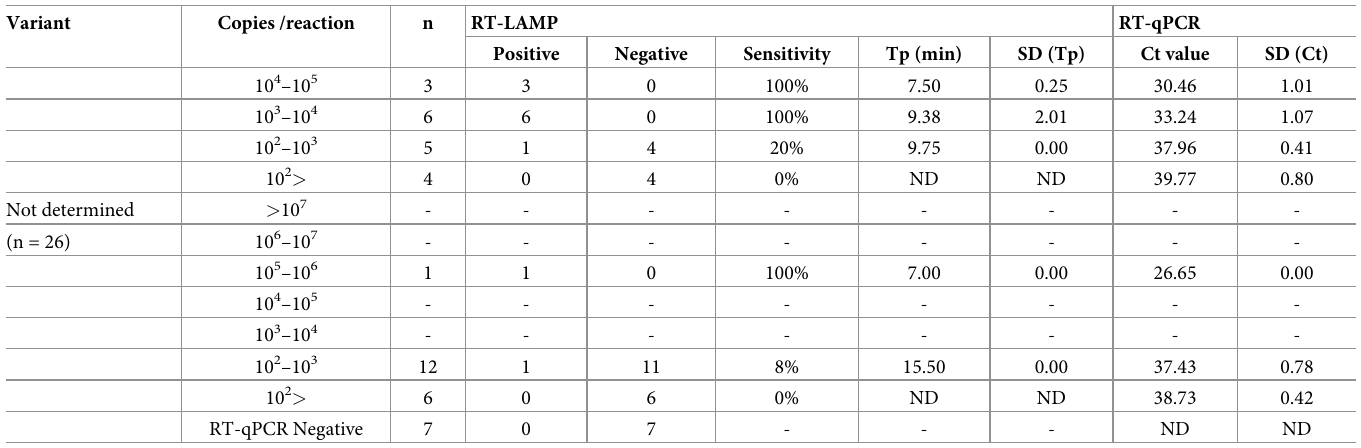
ND, not detected.